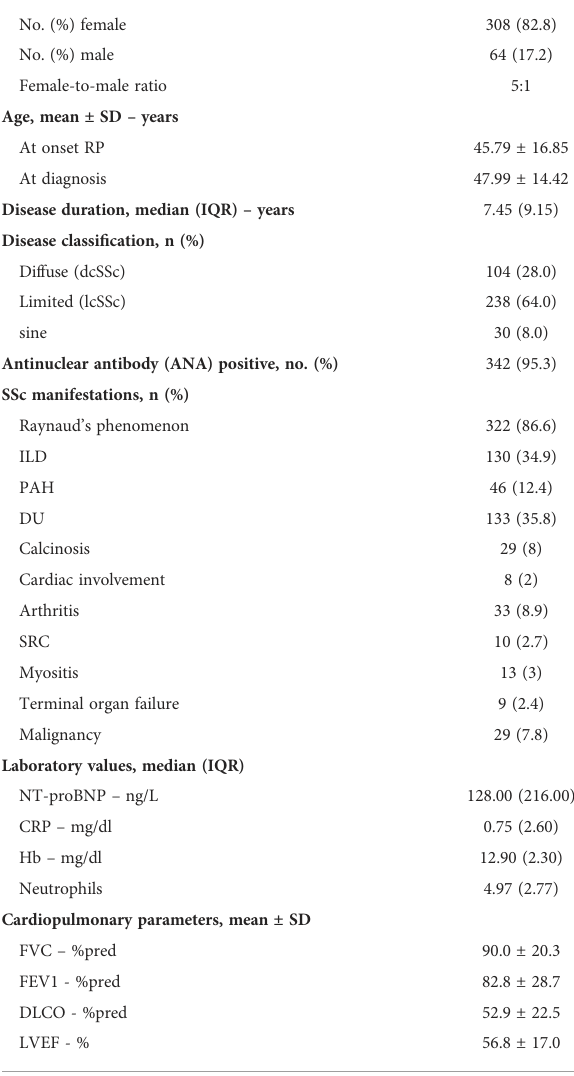
TABLE 1 Demographic, clinical, and serologic characteristics